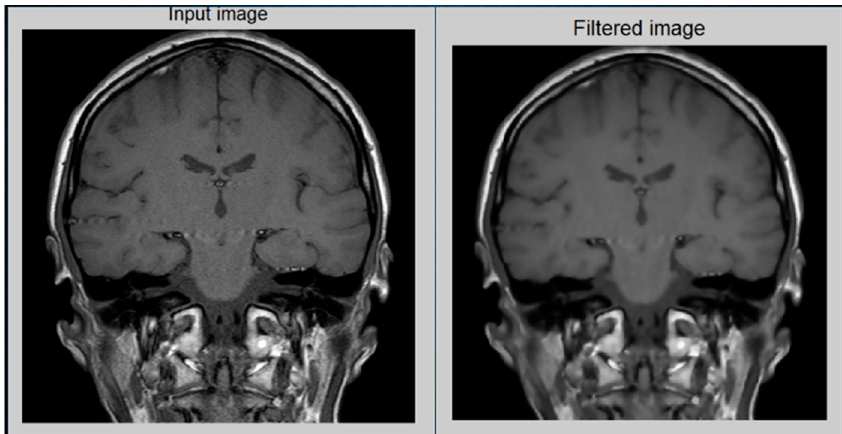
Figure 6. Left : original image; right : fi ltered image. Figure 6. ( Left ): original image; ( right ): filtered